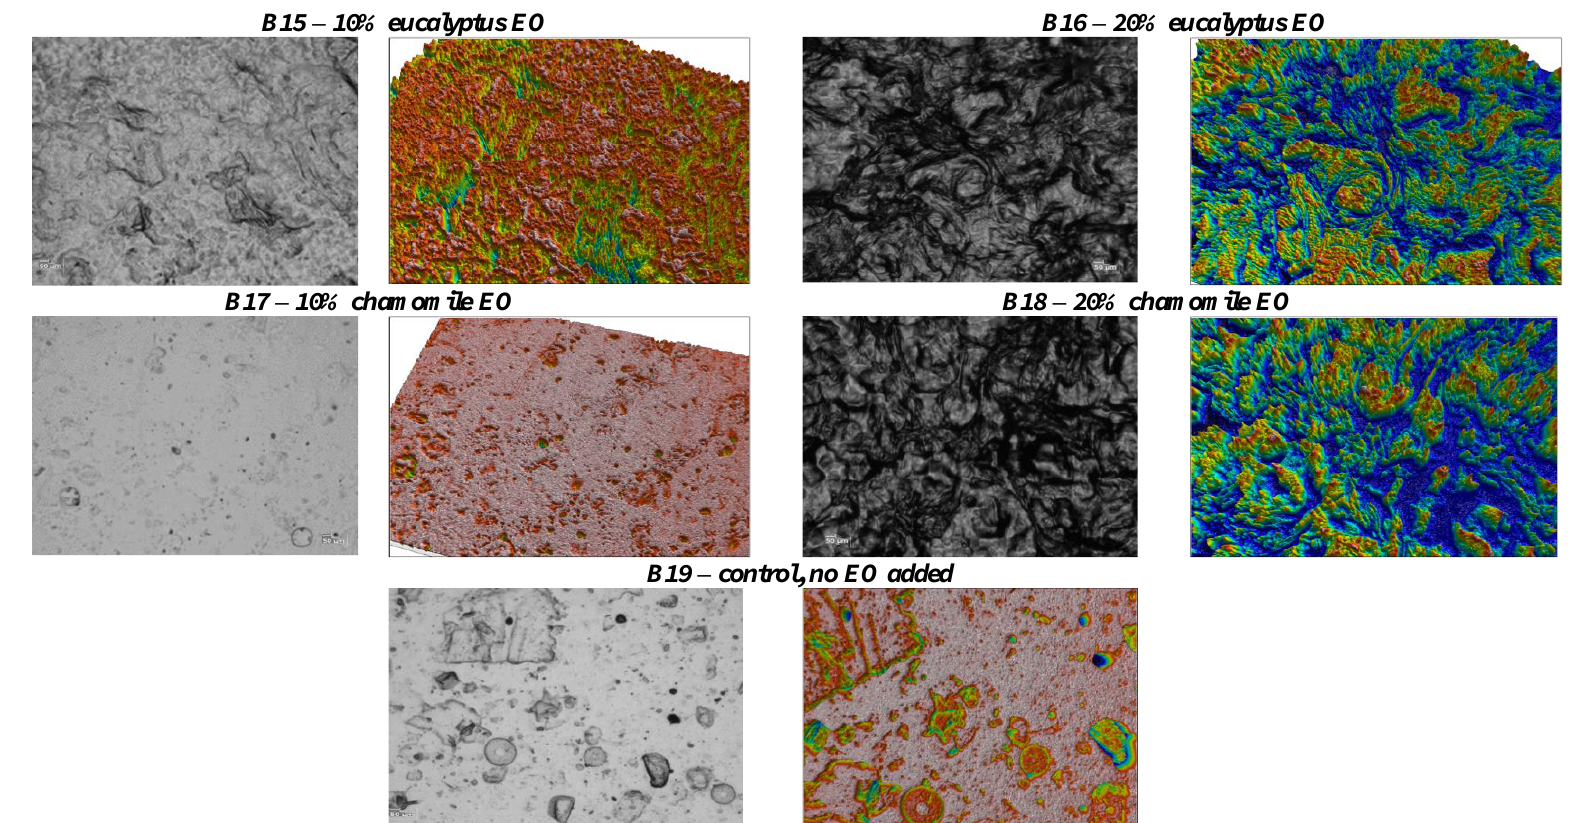
Figure 1. Microstructural and 3D microtopographical aspects of films developed with essential oils included.